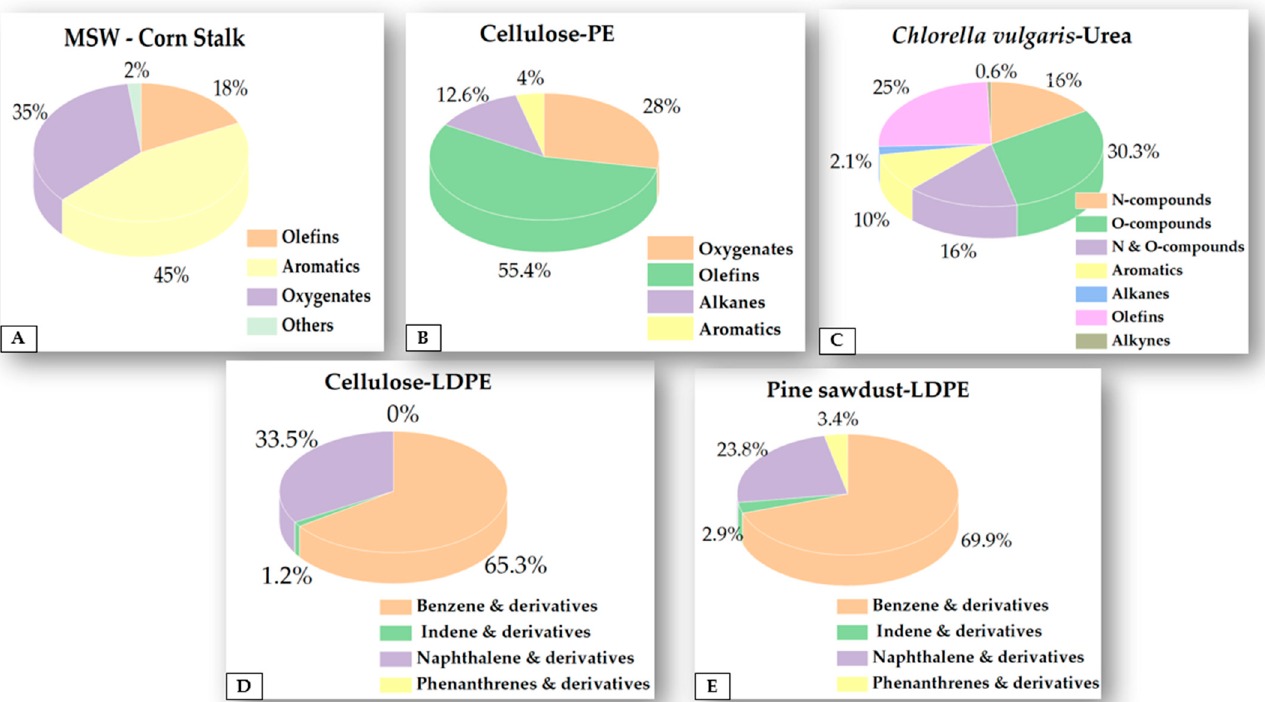
Figure 4. Comparison of articles on HZM: ( A ) MSW and cornstalk [25]; ( B ) CE and PE [35]; ( C ) Chlorella [28]; ( D , E ) CE and pine dust with LDPE [34].